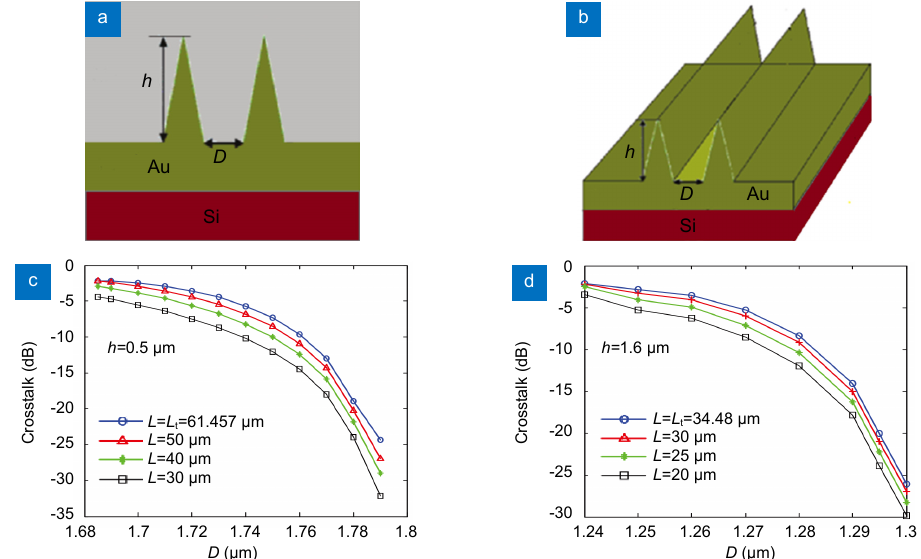
Fig. 3 | ( a ) The 2D and ( b ) 3D schematic diagrams of two WPP waveguides. Normalized crosstalk power of WPP waveguides under different parameters with wedge height ( c ) h= 0.5 μ m and ( d ) h= 1.6 μ m 32